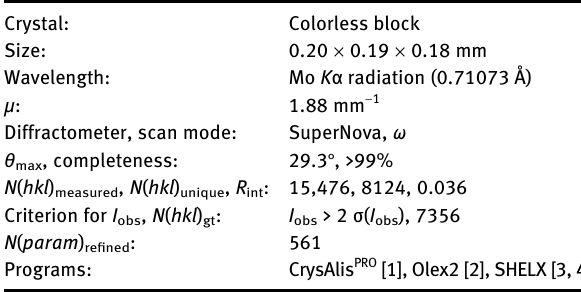
Table 1 contains crystallographic data and Table 2 contains the list of the atoms including atomic coordinates and displacement parameters.